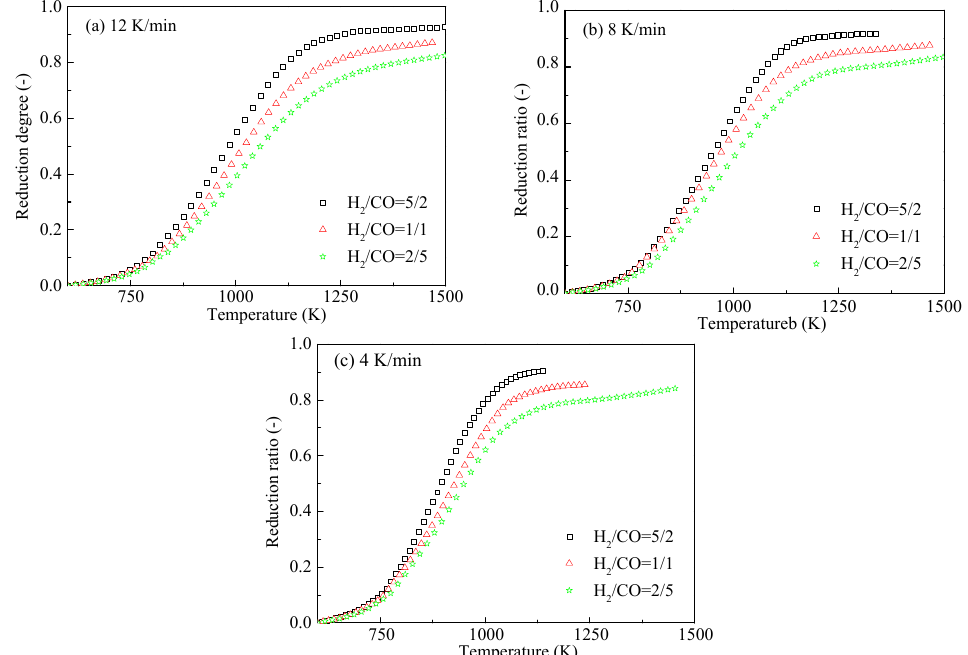
Figure 11. Effects of the reducing gas composition on the non-isothermal reduction ratio with different heating rates ( a ) 12 K/min; ( b ) 8 K/min; ( c ) 4 K/min. heating rates ( a ) 12 K/min; ( b ) 8 K/min; ( c ) 4